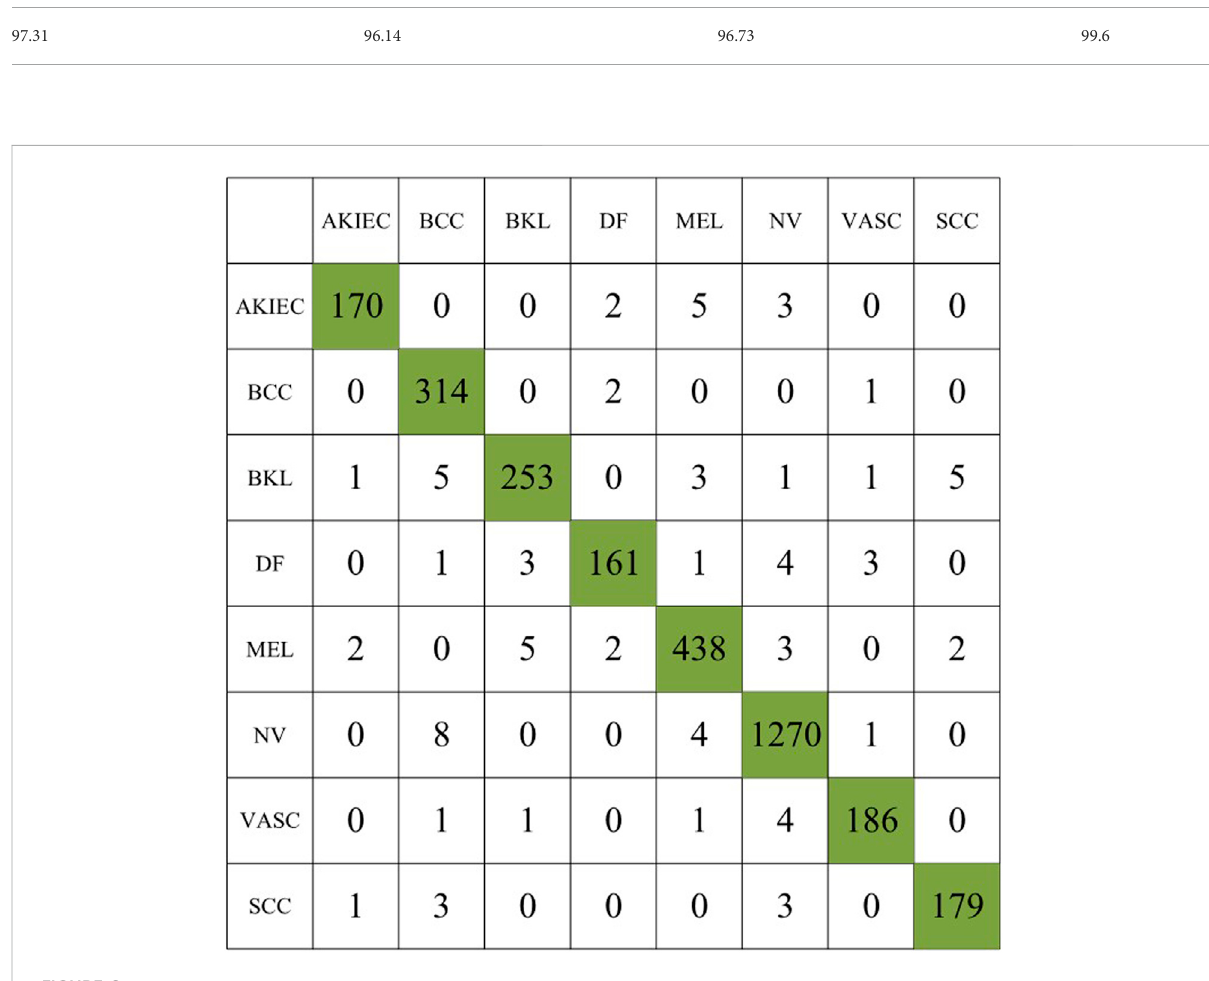
FIGURE 6 Confusion matrix for the second